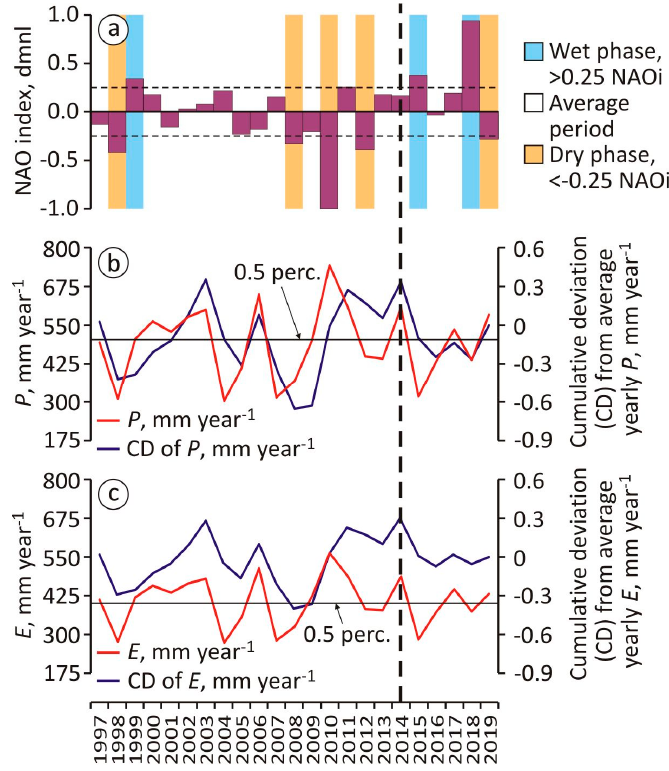
Figure 3. For natural years 1997–2019 in the SAL area, ( a ) normalized North Atlantic Oscillation (NAO) index (purple bars) [NAO website: http://www.cpc.ncep.noaa.gov/]; ( b ) annual precipitation (P) time series from Sines meteorological station and cumulative deviation (CD) from average annual P, mm year − 1 ; and ( c ) annual actual evapotranspiration (E) time series from Sines meteorological station and CD from average annual E, mm year − 1 . For ( b , c ), the average (0.5 percentile) of yearly data series is indicated. Vertical dotted line indicates the study year 2014. Table 3. Description of monitored variables in open